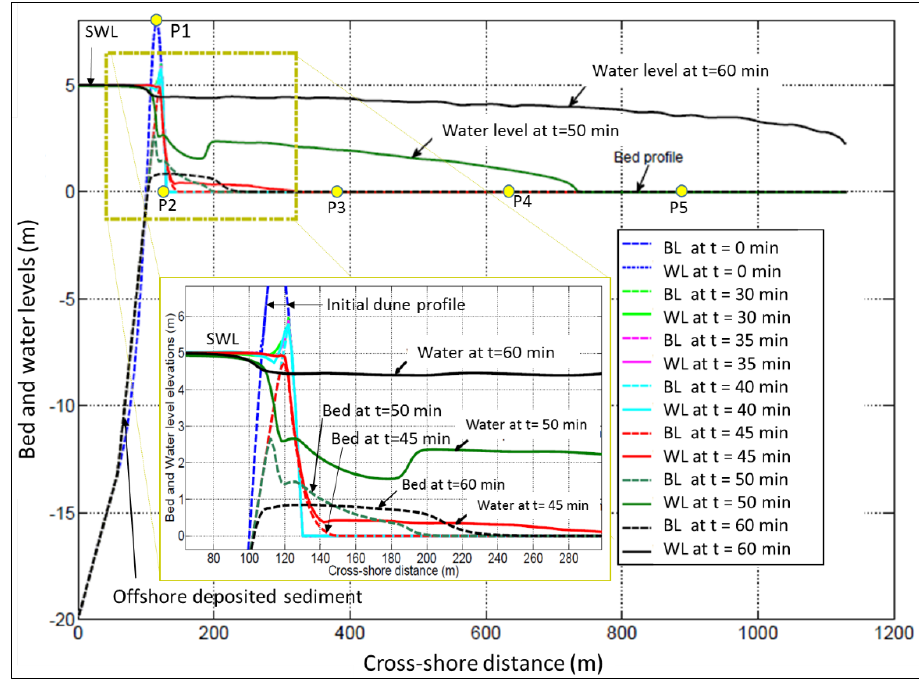
Figure 5. Evolution of the bed level (BL) and water level (WL) for the synthetic profile in Figure 1a under load case LC1 as defined in Figure 2.